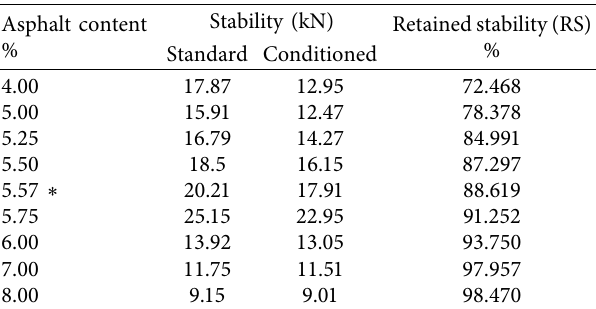
Table 15: Retained stability values of different bitumen content. Stability Asphalt content %